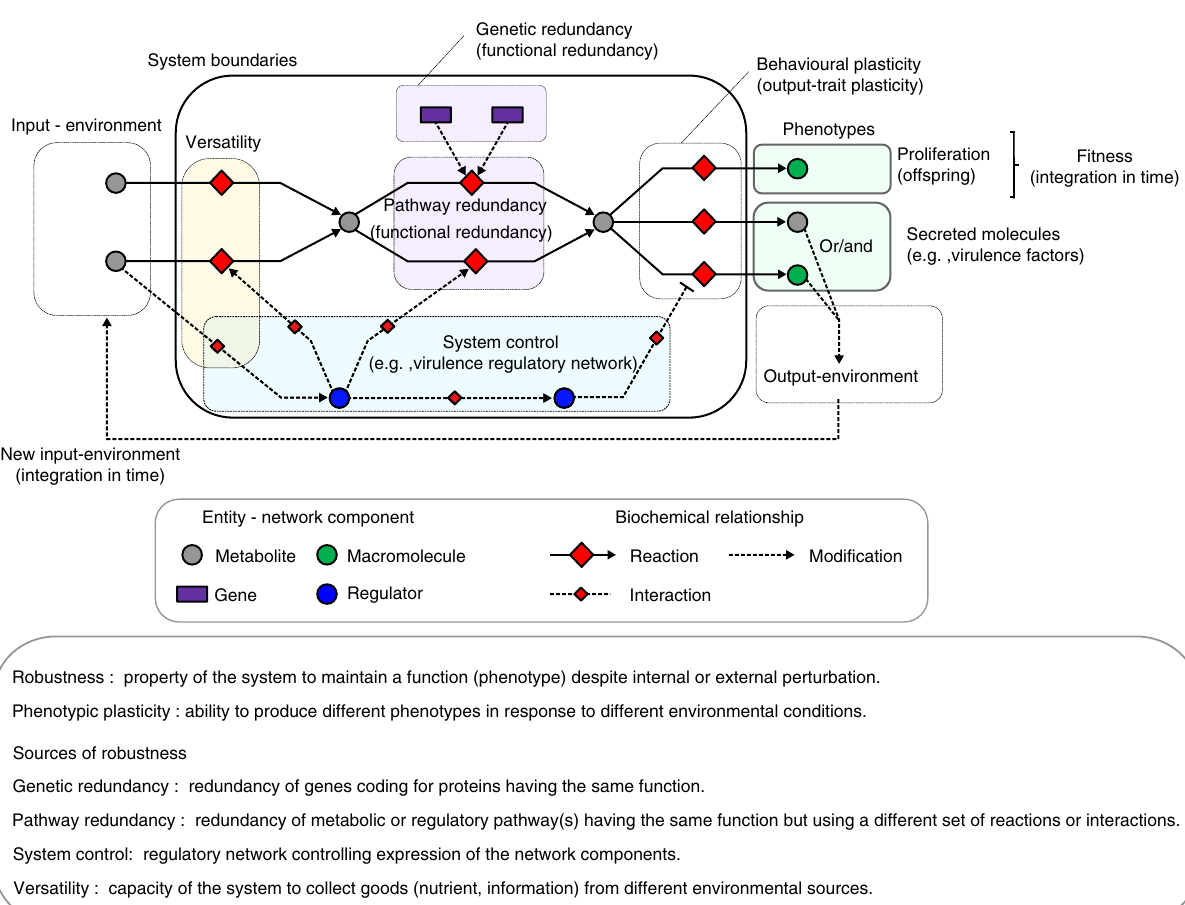
Genetic redundancy : redundancy of genes coding for proteins having the same function. Pathway redundancy : redundancy of metabolic or regulatory pathway(s) having the same function but using a different set of reactions or interactions. System control: regulatory network controlling expression of the network components. Versatility : capacity of the system to collect goods (nutrient, information) from different environmental sources.